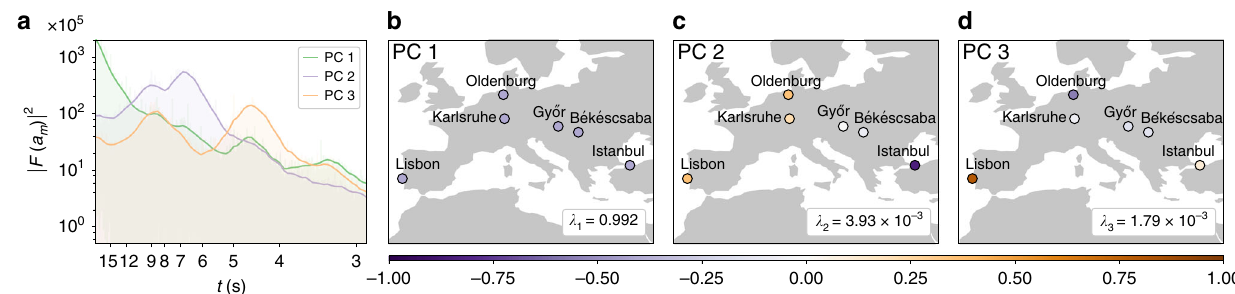
Fig. 9 Principal component analysis (PCA) of frequency recordings reveals inter-areas oscillations. a In Continental Europe, the squared Fourier (cid:5) (cid:3) (cid:4)(cid:5) (cid:5) (cid:5) 2 of the three dominant principal components (PCs) exhibits typical period lengths of t ≈ 7 s and t ≈ 4.5 s. b While the fi rst spatial amplitudes F a m ð t Þ mode (PC1) corresponds to the bulk behaviour of the frequency and explains already λ 1 = 99.2% of the total variance, the second (PC2) and third (PC3) mode reveal asynchronous inter-area modes ( c , d ). We refer to Supplementary Note 6 for details on the method and the